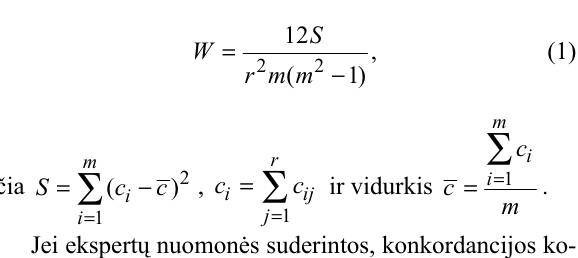
ėpurgųtrepske3 )iakninilsrev(